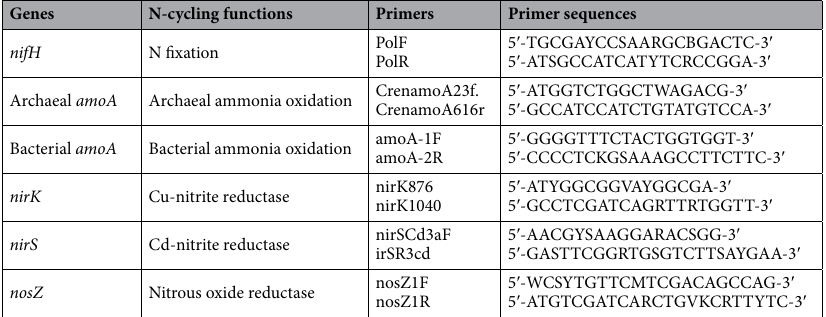
Table 4. N-cycling genes primers used for qPCR quantification